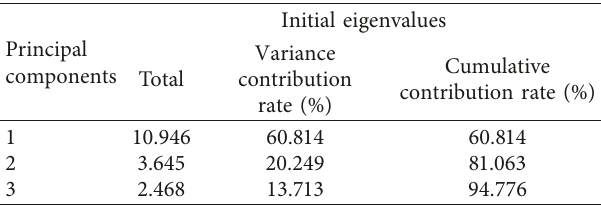
Figure 5: 3D diagram of principal component score. Table 5: Eigenvalues and contribution rates of principal components.